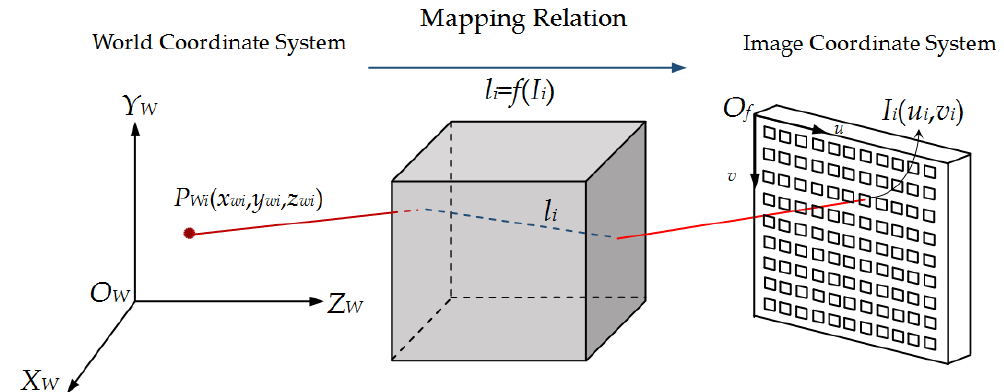
Figure 3. General imaging model. P Wi is the world coordinate of the target point. I i is the image coordinate corresponding to the target point. l i is the mapping relation expressed by Plücker Coordinate.